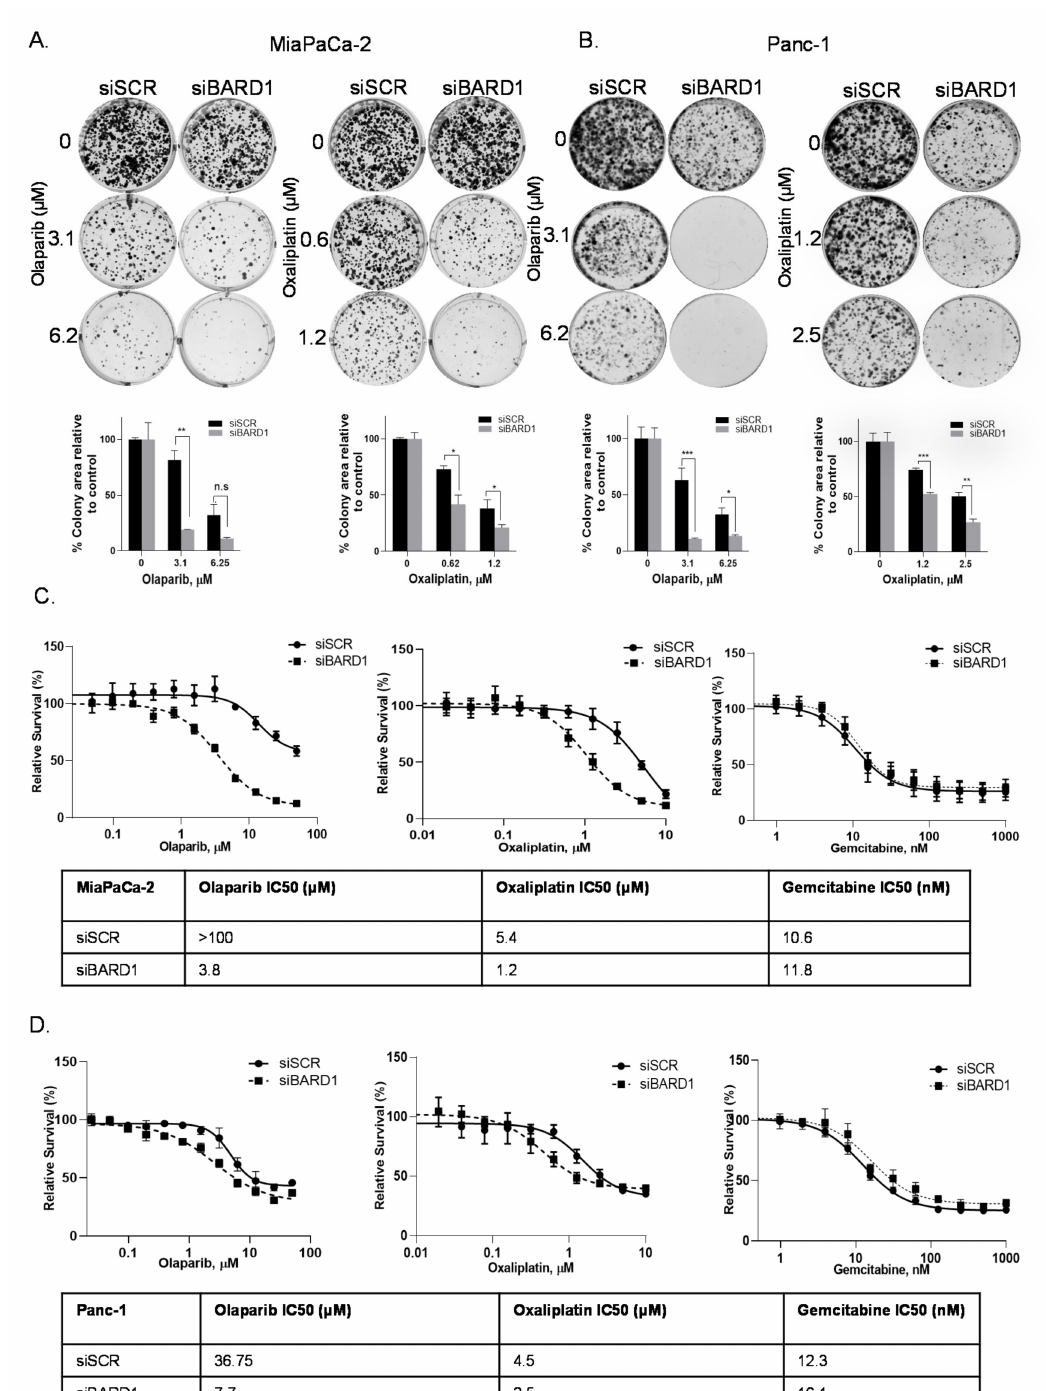
Figure 4. BARD1 supports PDAC growth and modulates drug responses. ( A , B ) Colony formation assays in BARD1 silenced (siBARD1#1), and MiaPaCa-2 and Panc-1 cells treated with either olaparib or oxaliplatin at indicated concentrations; colonies were stained with Coomassie blue after 14 days. Graphs of Mean ± SEM from n = 3 are shown. * p < 0.05, ** p < 0.01, *** p < 0.001, n.s, non- significant. (Student’s t -test). ( C , D ) Pico Green cell survival curves in BARD1 silenced (siBARD1#1), and MiaPaCa-2 cells and Panc-1 cells were treated with either olaparib, oxaliplatin, or gemcitabine for 5 days. Representative graphs from n = 3 are shown. IC50 doses are shown in the